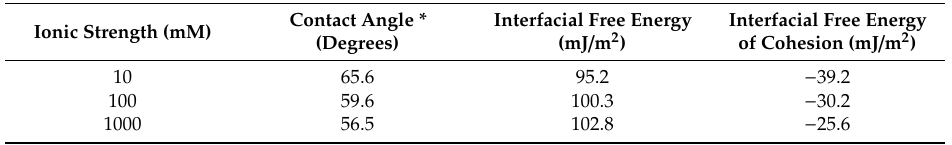
Table 1. Contact angle and zeta potential as a function of pH for DuPont-FilmTec (Edina, MN, USA) XLE membrane at constant, 10 mM sodium chloride solution. Used with Permission of Elsevier B.V. [40]. pH (Standard Units) Contact Angle (Degrees) Zeta Potential (mV) 3 62 ± 2.4 + 20.6 61 ± 2.8